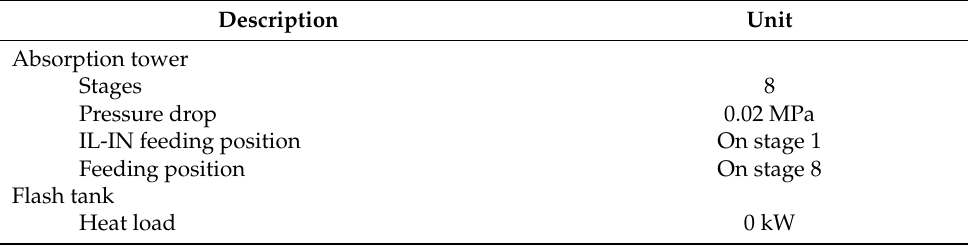
Table 5. Key parameters for the CO 2 capture of the main